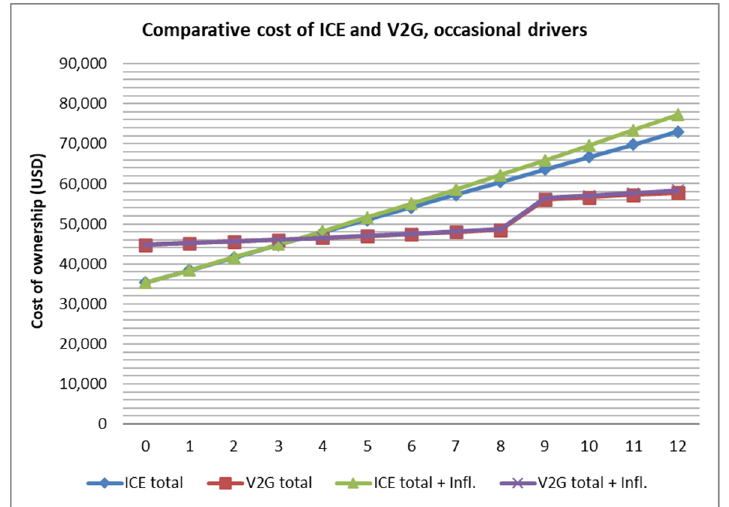
Figure 6. Graphical representation of the calculation results for occasional drivers.